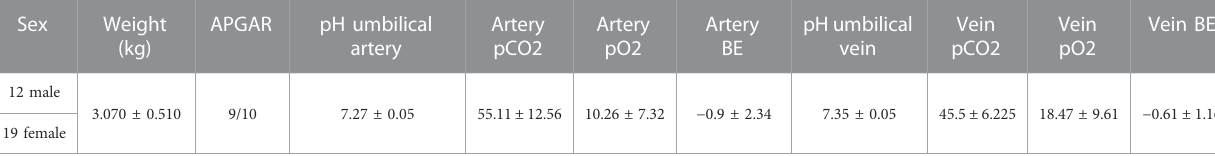
TABLE 1 Newborn data sex, weight (kg), APGAR score, pH, pO2, pCO2, and BE for both umbilical artery and